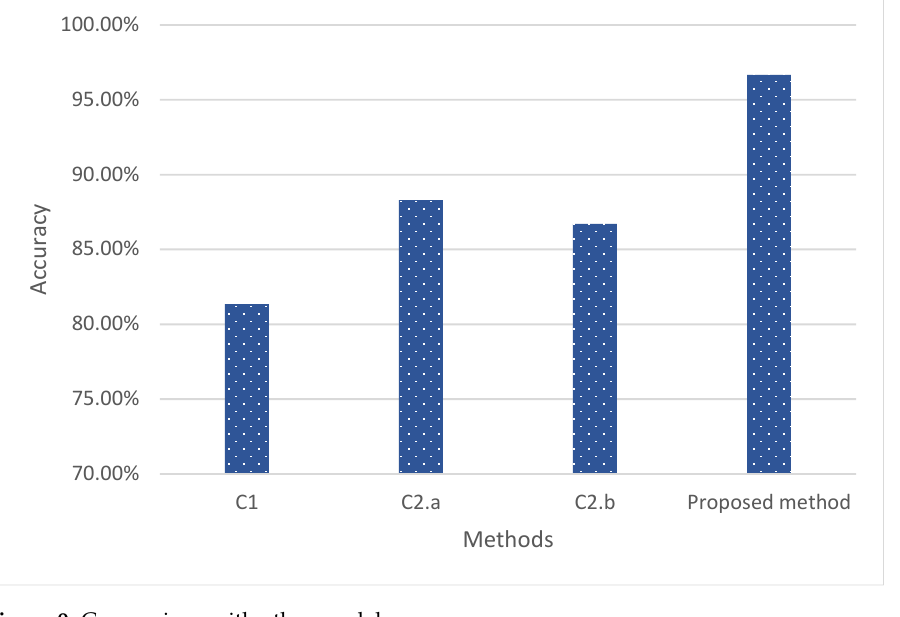
Figure 9. Comparison with other models. Table 6. Comparison with literature